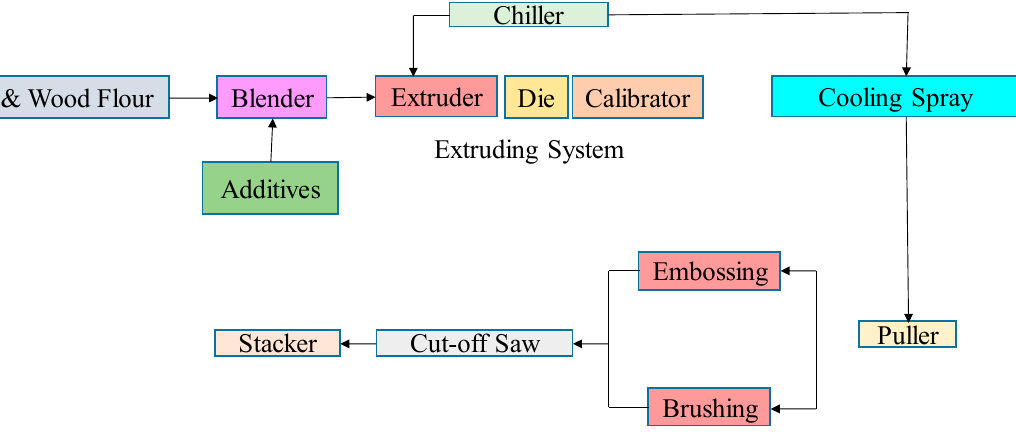
Figure 5. Process flowchart of WPC manufacturing process with extrusion system.